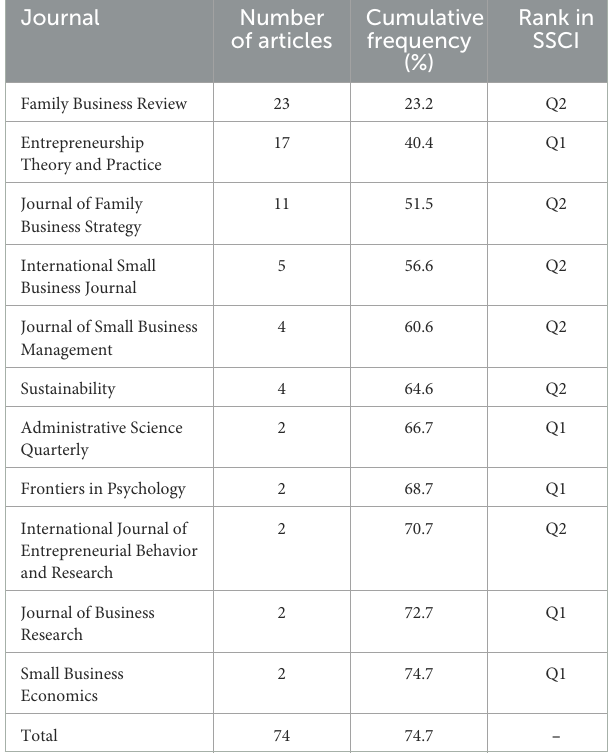
TABLE 2 Number of articles on the identity perspective per journal ( > 1